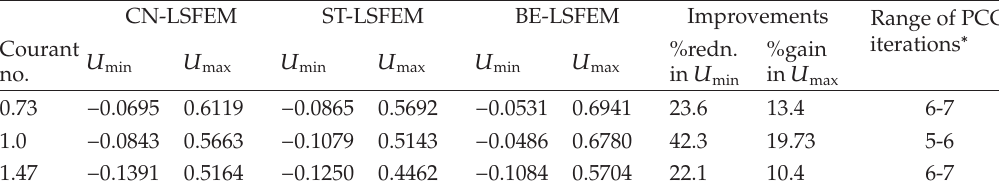
Table 3: Advection of concentration spike by t (cid:9) 1 . 3.